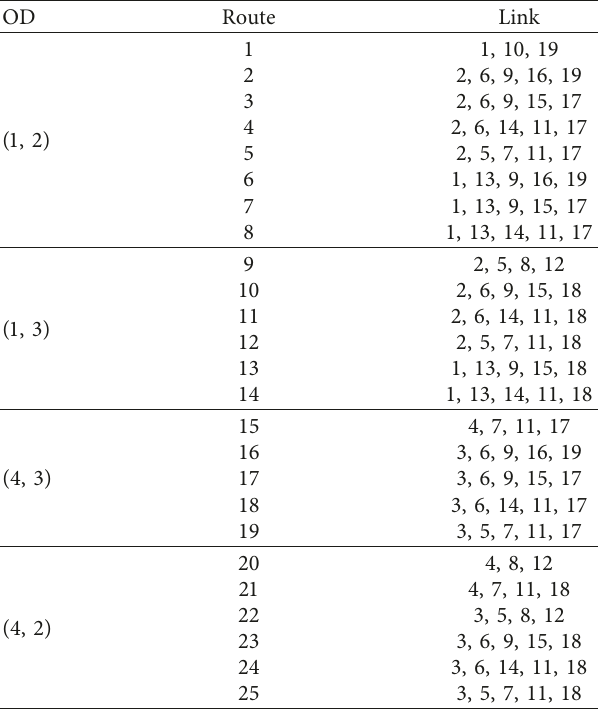
Table 10: Route flow and cost in mixed equilibrium for travellers in the first